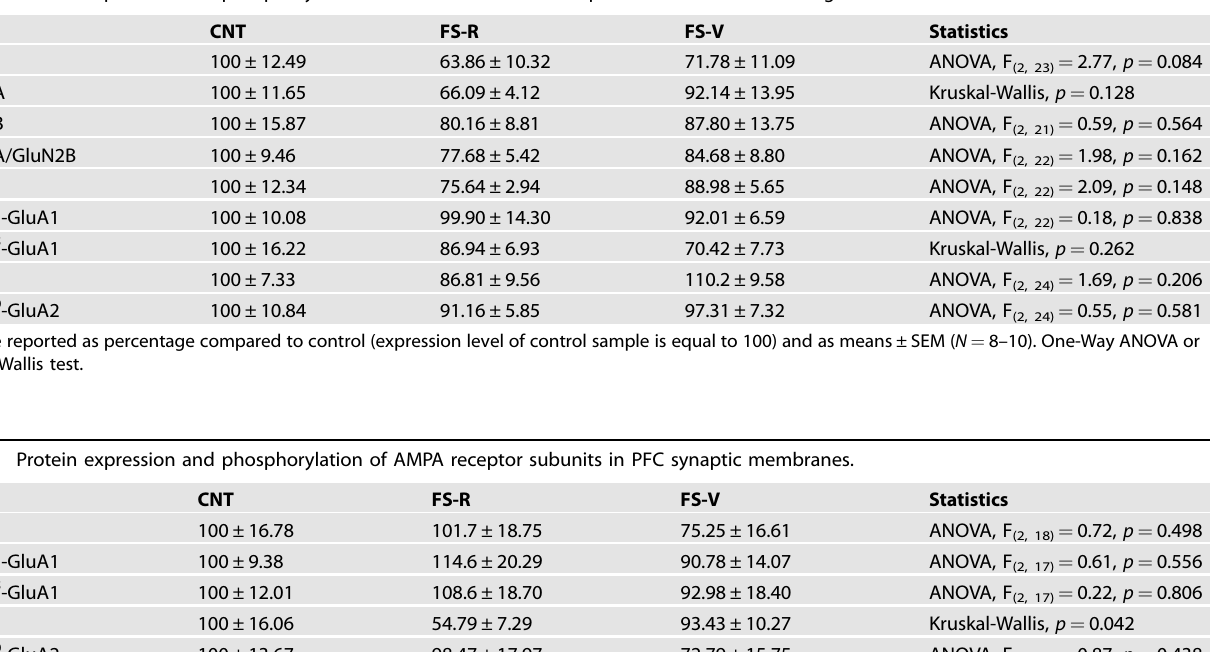
Table 1. Protein expression and phosphorylation of AMPA and NMDA receptor subunits in PFC homogenates.